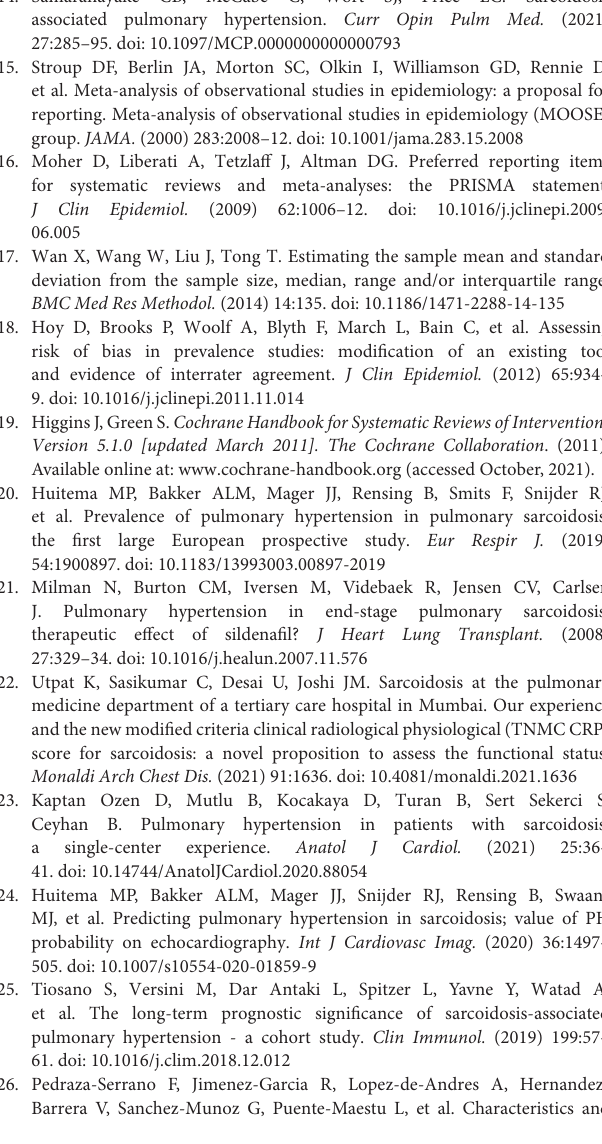
Supplementary Table 4 | Risk of bias quality assessment tool. Supplementary Table 5 | Quality assessment of included